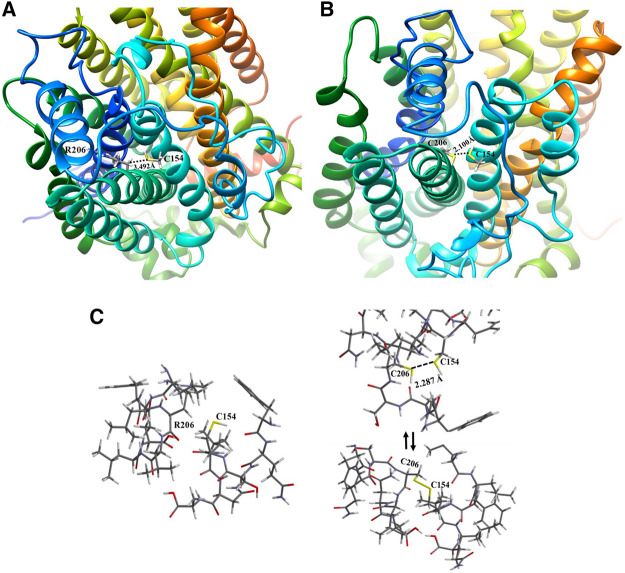
Comparative representation of the effect of the R206C variant: (A) 3D visualization of the hOCT1 wild type R206 channel structure; (B) 3D visualization of the hOCT1 channel mutated at C206; (C) Energy optimization of the neighboring amino acids for R206 and C154 in TM2 and TM3 of the hOCT1 wild type channel (left side); Energy optimization at C206 and C154 with no disulfide bridge between TM2 and TM3 (upper right side); Balanced energy optimization with a closed disulfide bridge for C206 and C154 (bottom right side).